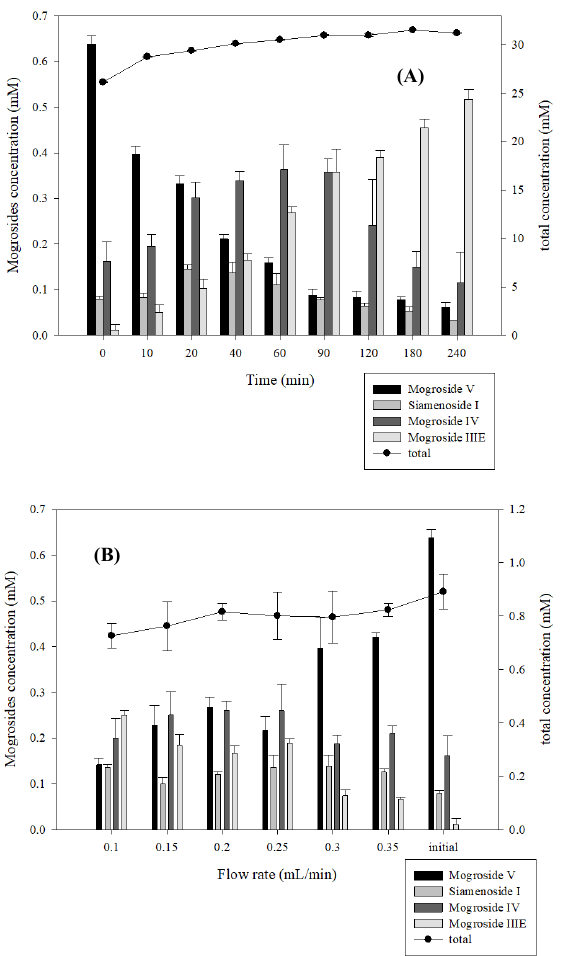
Figure 6. The result of immobilized β -glucosidase converting mogrosides at different times ( A ), and using the bioreactor to convert mogrosides by different flow rates ( B ). Each value is expressed as mean ± SD.